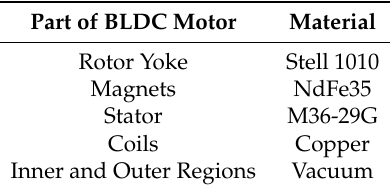
Table A2. Material